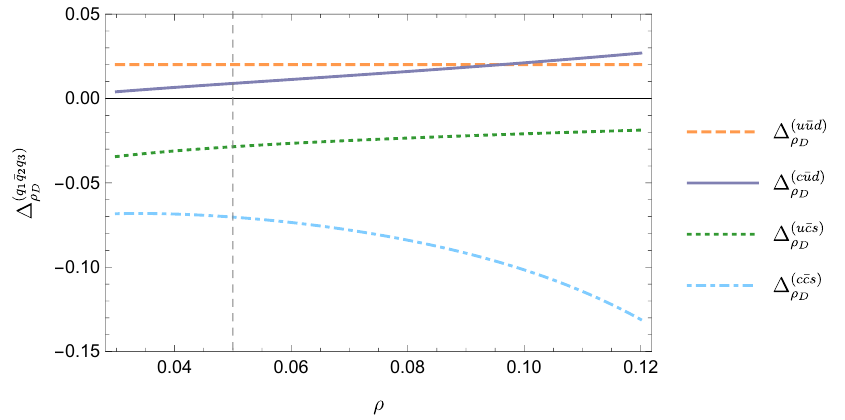
Figure 7 . Total relative size of the Darwin term correction compared to the partonic-level contri- bution for different modes, including b → u ¯ ud (dashed orange), b → c ¯ ud (solid purple), b → u ¯ cs (dotted green) and b → c ¯ cs (dot-dashed cyan). For reference we have fixed the values µ 1 = µ 0 = m b , m b = 4 . 5 GeV and ρ 3 = 0 . 2 GeV 3 . The dashed vertical line shows the approximate value ρ = 0 . 05 D in the MS